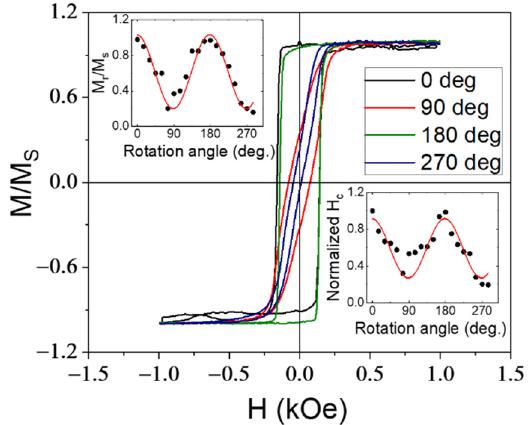
Figure 7. MOKE loops of FeCo structures with a thickness of 15 nm deposited on Mo with linear trenches, collected at different azimuthal angles with respect to the direction of trenches; Angular representation of the relative remanent magnetization and normalized coercive field are shown in insets.